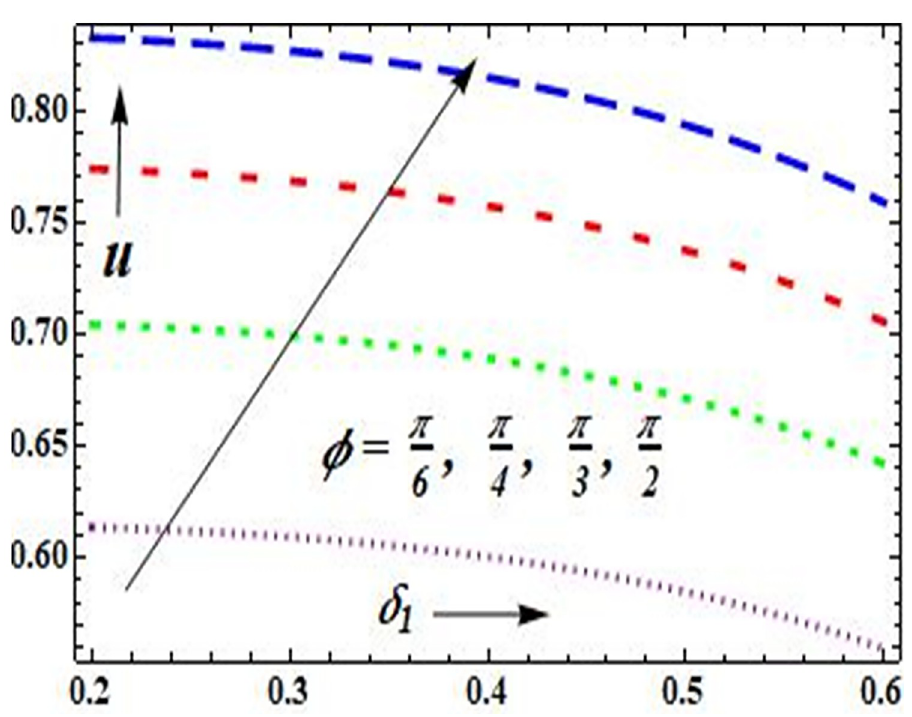
Fig 22. Plot of u on ϕ & δ 1 with M = 2.0, d 1 = 0.2, F = 0.3, d 2 = 0.6, L 2 = L 1 = 0.2, r = 0.2.